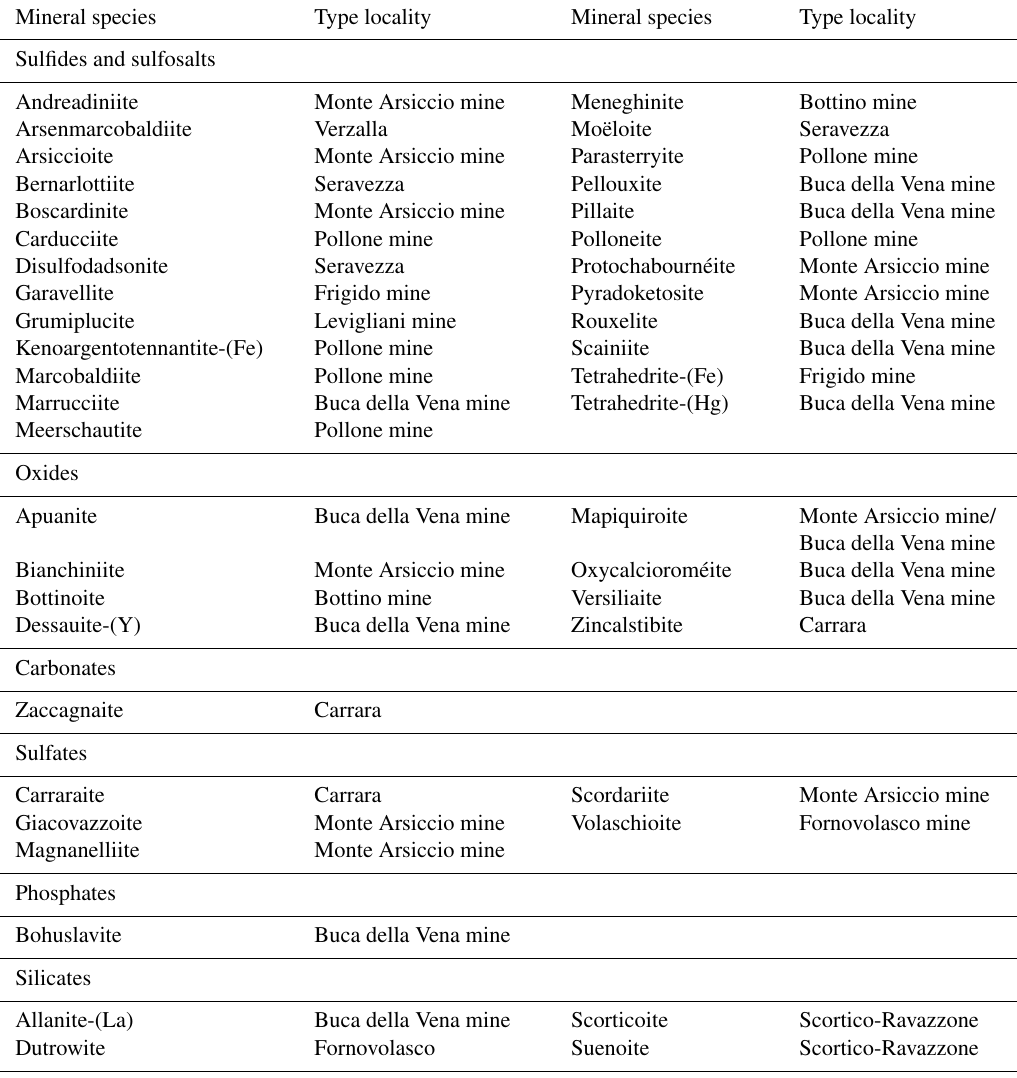
Table 1. New mineral species from the Apuan Alps (Tuscany, Italy). Mineral species Type locality Mineral species Type